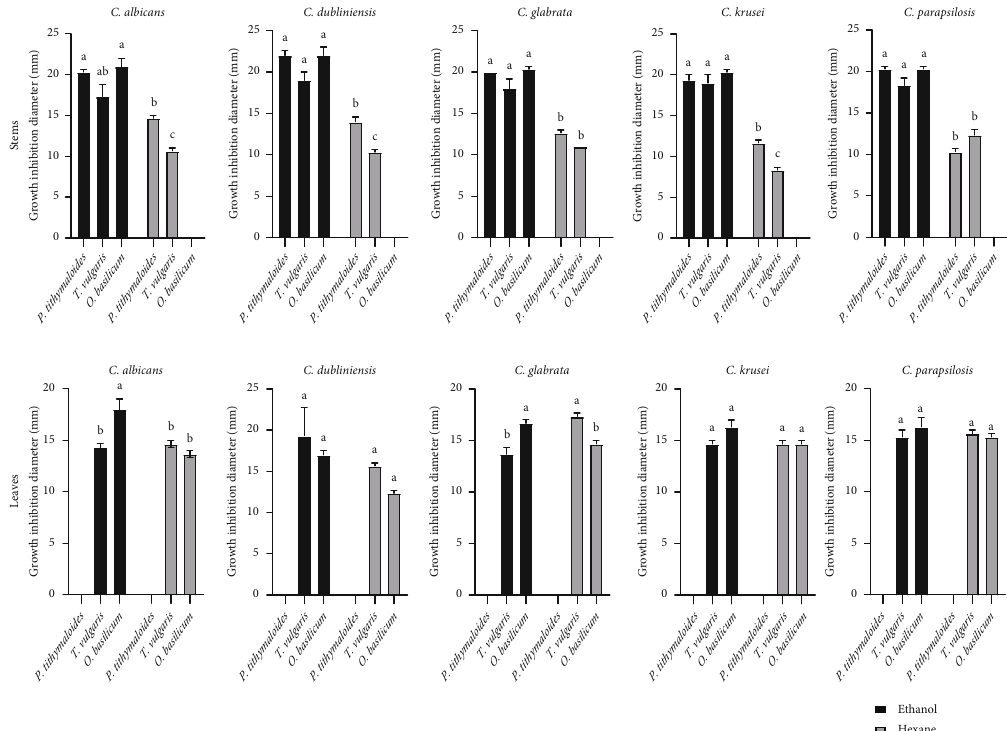
Figure 4: Diameters of the inhibition halos of the P. tithymaloides , T. vulgaris , and O. basilicum extracts from stems and leaves (horizontal layout) against the fi ve Candida species at an OD 0.1 (vertical layout). Black and dark gray bars represent ethanolic and hexanoic 600nm extracts, respectively. Di ff erent letters indicate signi fi cant di ff erences between treatments (Tukey ’ s test p ≤ 0 : 05 ). Error bars indicate the standard error of the mean (SEM, n = 3